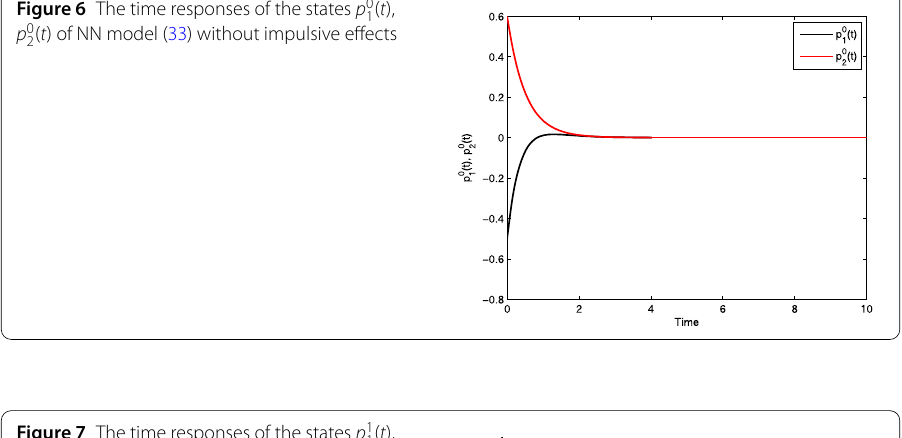
Figure 7 The time responses of the states p 1 1 ( t ), p 1 2 ( t ) of NN model (33) without impulsive effects